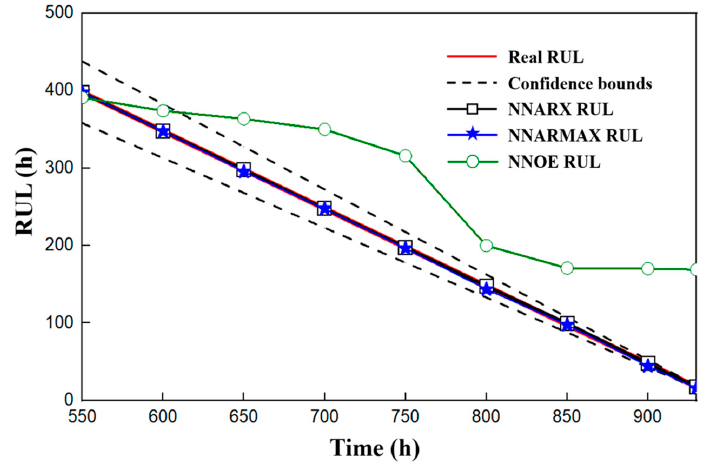
Figure 9. Uncertainty analysis of RUL estimation within different models.